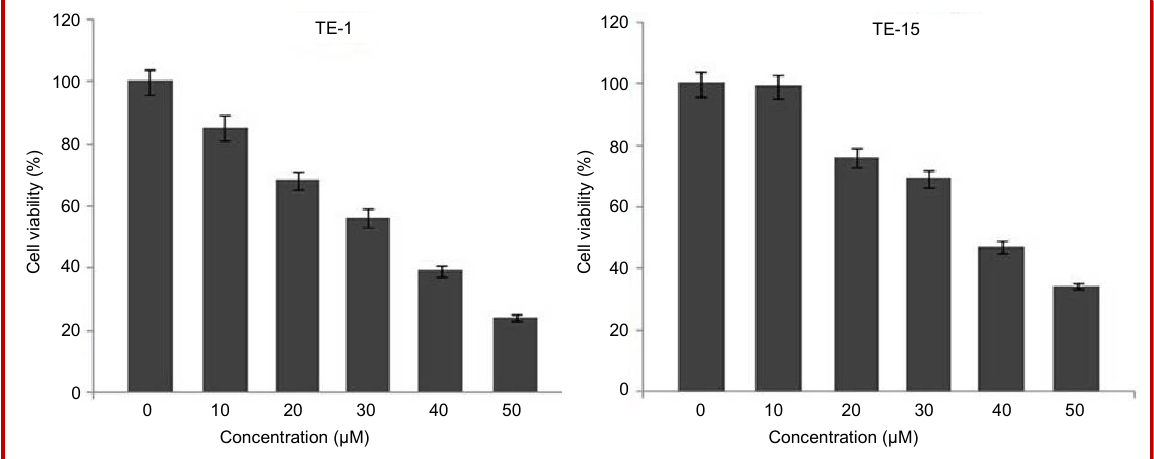
Figure 1: Casticin inhibited cell viability of TE-1 and TE-15 squamous carcinoma cell lines. The cells were treated with various concentrations of casticin or left untreated (as control) for 48 hours. Absorbance was measured at 565 nm to determine the cell viability